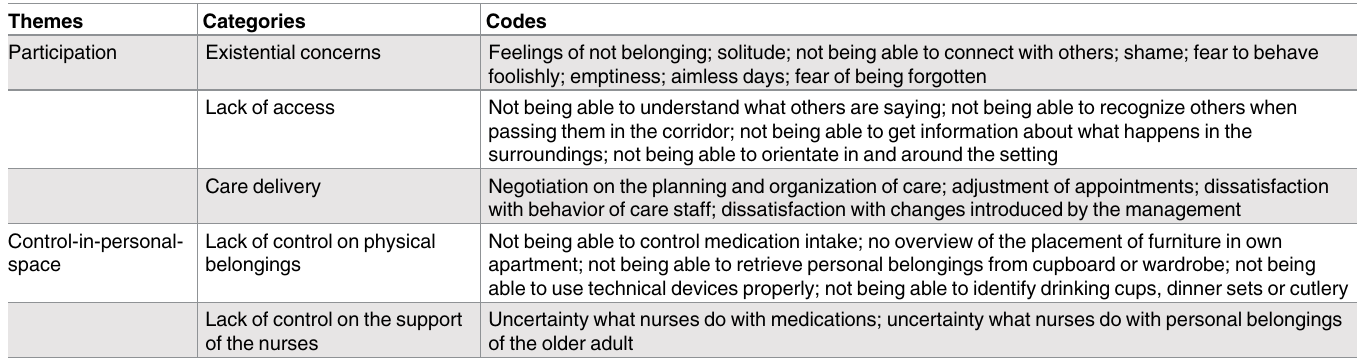
Table 1. Problems identified by the older adults using the